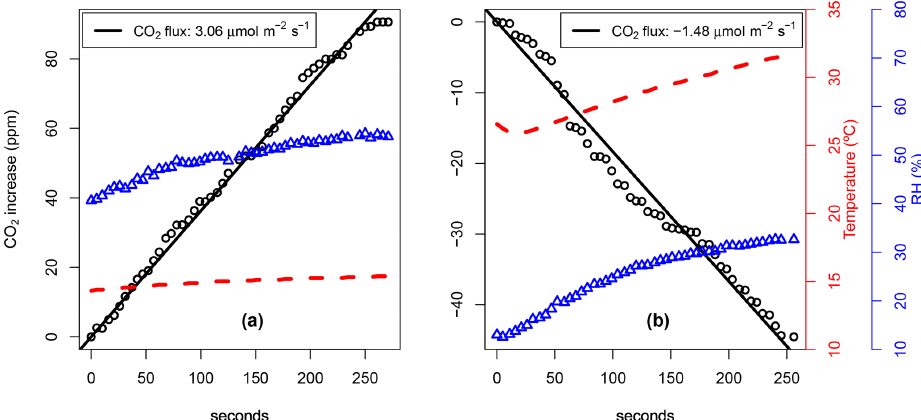
Figure 7. Example of two cases where the linear accumulation method was applied within an NSS-NTF chamber to calculate positive (a) and negative (b) CO 2 fluxes with kit no.